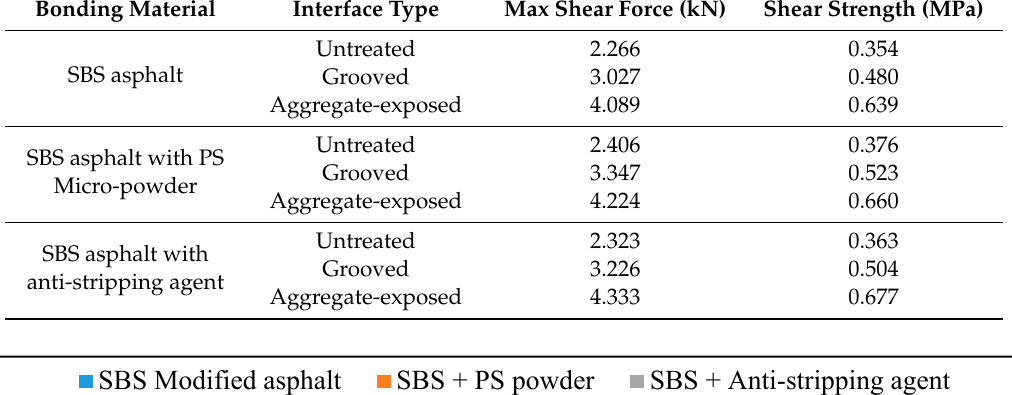
Table 4. Interlaminar shear strength of di ff erent waterproof and cohesive materials.